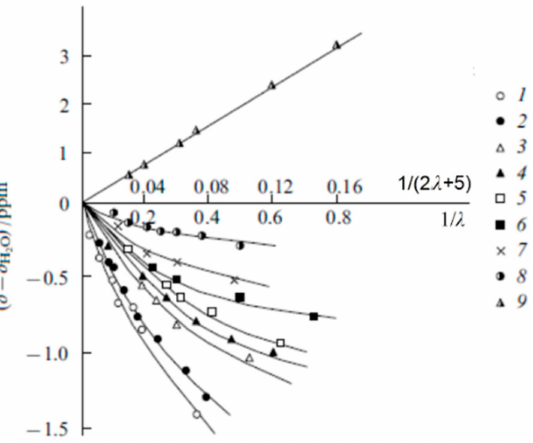
Figure 9. Dependences of chemical shifts of water on the moisture content of MF-4SC membrane. Membrane ionic form: (1) Li + , (2) Na + , (3) K + , (4) Rb + , (5) Cs + , (6) Ba 2+ , (7) Ca 2+ , (8) Mg 2+ , (9) H + (adapted from [19]).